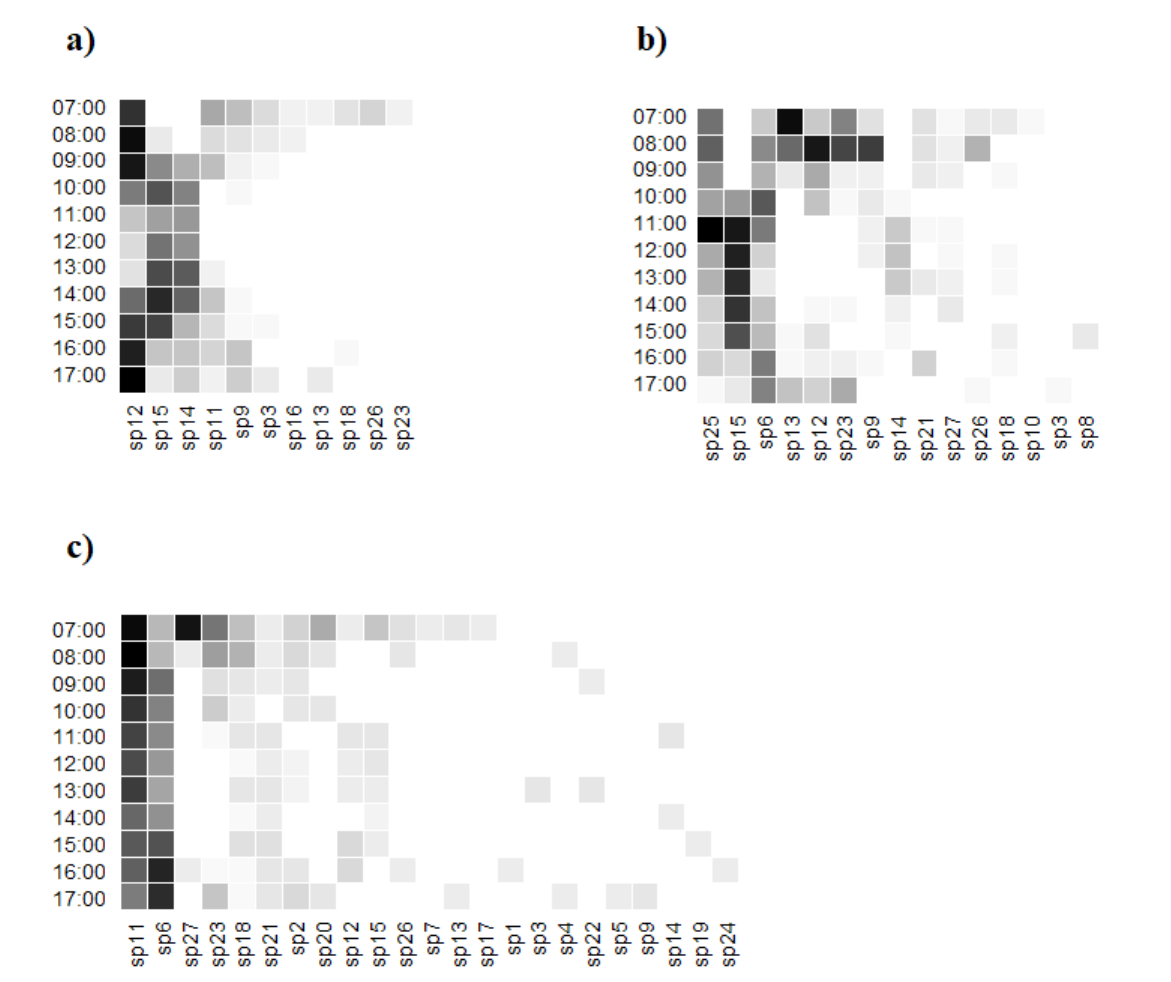
Fig 5. Matrices of occurrence of ant species at each hour of the day in the studied phytophysiognomy: (A) Grassland; (B) Shrub Caatinga; (C) Arboreal Caatinga. The gray scale represents the abundance of individuals by species. The code of species: sp1: Azteca sp; sp2: Blepharidatta conops; sp3: Brachymyrmex admotus; sp4: Brachymyrmex heeri; sp5: Camponotus cameranoi; sp6: Camponotus crassus; sp7: Camponotus melanoticus; sp8: Cephalotes pusillus; sp9: Crematogaster victima; sp10: Dinoponera quadríceps; sp11: Dorymyrmex bicolor; sp12: Dorymyrmex brunneus; sp13: Ectatomma muticum; sp14: Forelius brasiliensis; sp15: Forelius maranhaoensis; sp16: Kalathomyrmex emeryi; sp17: Odontomachus bauri; sp18: Pheidole diligens; sp19: Pheidole fallax; sp20: Pheidole fimbriata; sp21: Pheidole meinerti; sp22: Pheidole obscurithorax; sp23: Pheidole radoszkowskii; sp24: Pseudomyrmex urbanus; sp25: Solenopsis substituta; sp26: Solenopsis globularia; sp27: Solenopsis